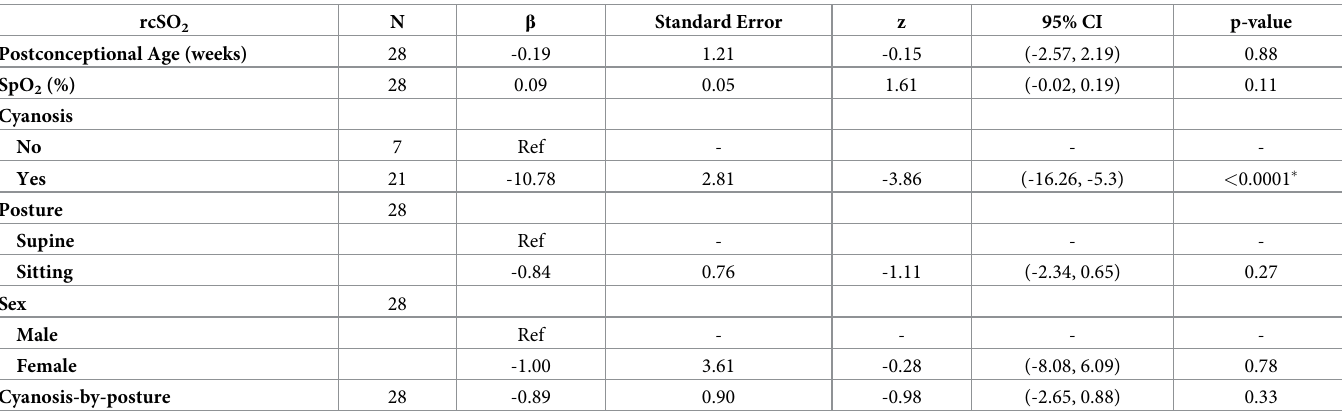
Generalized estimating equation assessed the associations of cyanotic vs. non-cyanotic defects and posture with rcSO 2 values. The main effect of cyanosis tested our hypothesis of reduced cerebral oxygen saturation, and the cyanosis-by-posture interaction tested our hypothesis of cerebrovascular instability in cyanotic CHD. Covariates in the model were postconceptional age, SpO 2, and sex. CHD = congenital heart disease; rcSO 2 = regional cerebral oxygen saturation; SpO 2 = preductal peripheral oxygen saturation. � p < 0.05.